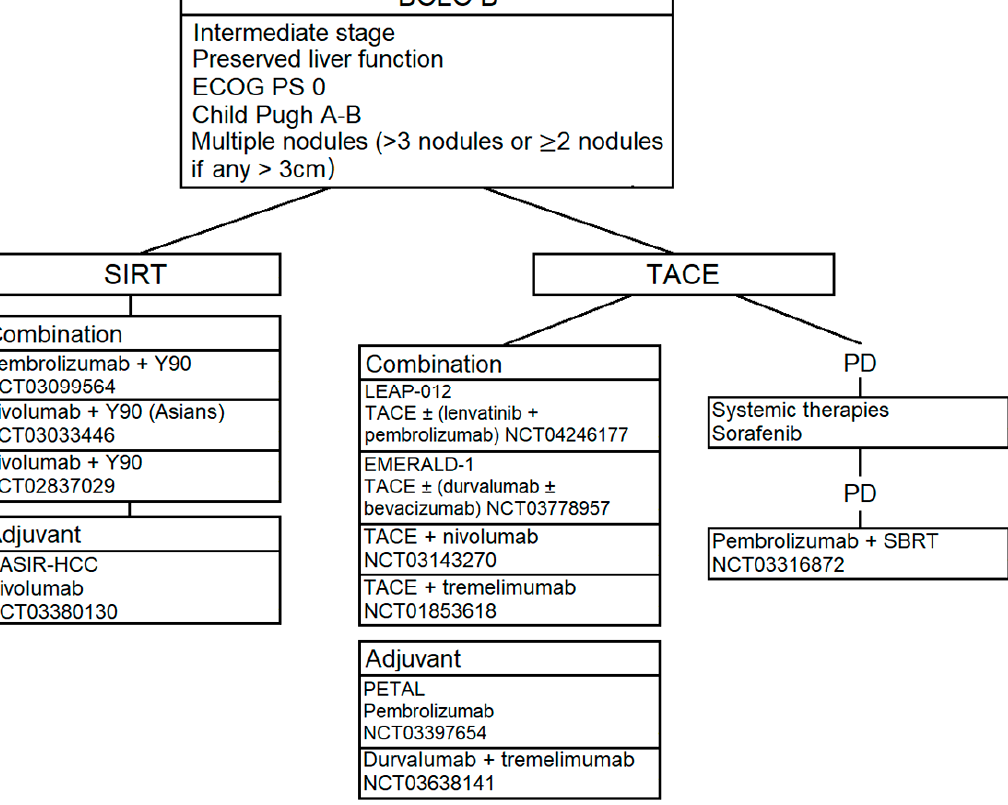
Figure 3. Treatment options and ICIs ongoing clinical trials for BCLC stage B.